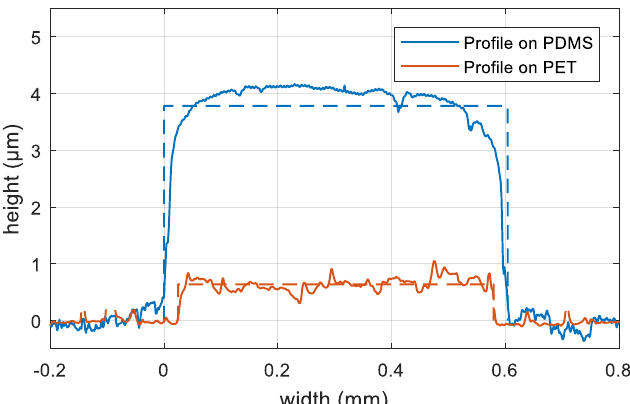
Figure 2. Height profile of inkjet-printed silver lines on PDMS and PET. Horizontal dashed lines show the average height of 3.8 µm and 0.6 µm, respectively, calculated over the line width marked by vertical dashed lines.